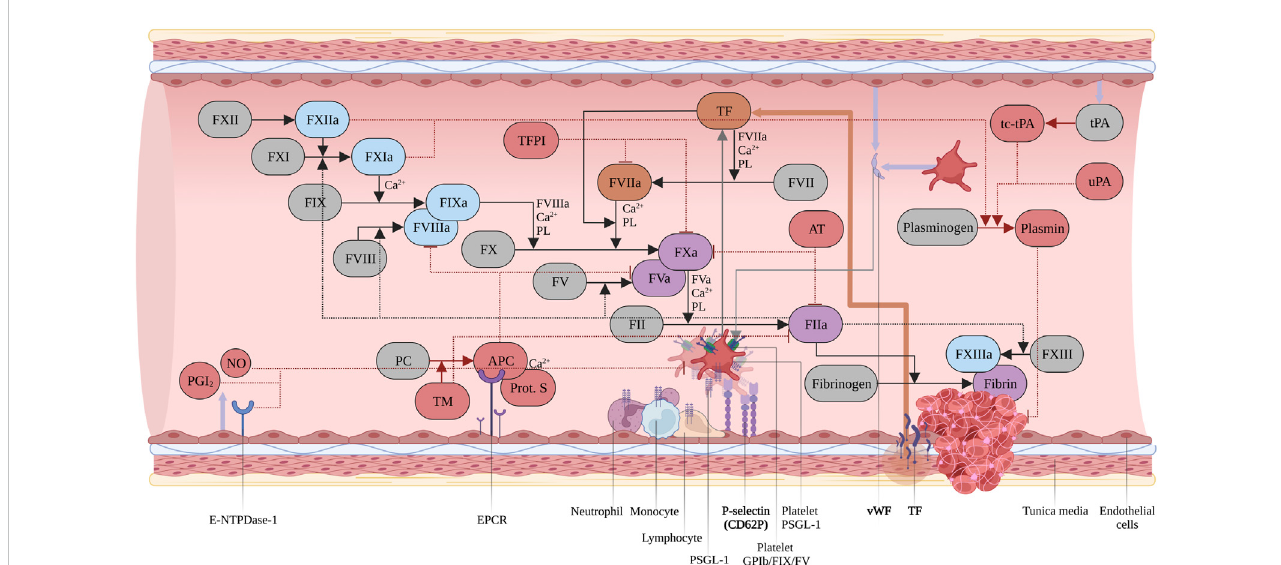
FIGURE 1 Coagulation cascade.Intrinsicpathwayinlightblue,extrinsicpathwayinorange,commonpathwayinpurple.Inhibitorsandmodulatorsofhemostasisin red. Zymogens in grey. Abbreviations: Tissue Factor Protein Inhibitor (TFPI); Phospholipids (PL); Two-chains, tissue-type Plasminogen Activator (tc-tPA); Urokinase Plasminogen Activator (uPA); Protein C (PC); activated Protein C (APC); Thrombomodulin (TM); Prostaglandin I 2 (PGI 2 ); Nitric Oxide (NO). Created with